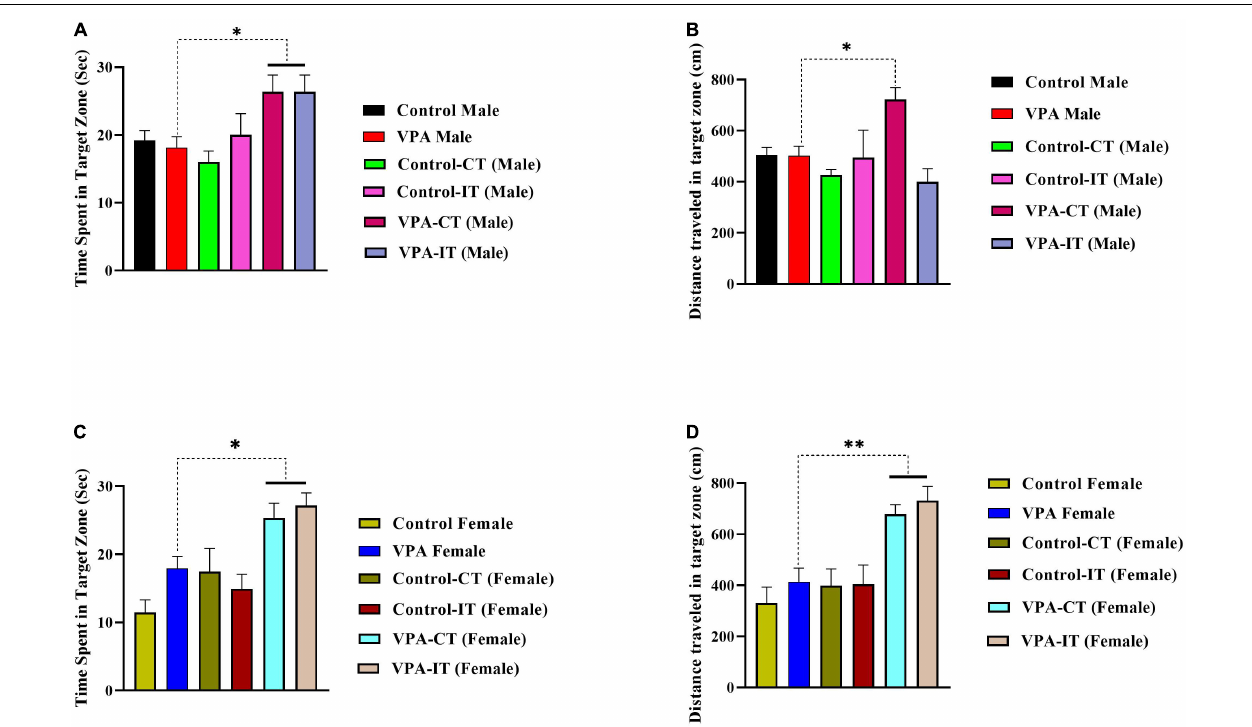
FIGURE 7 | The effects of IT or CT on the MWM probe trial reference memory in the control and VPA-exposed male and female offspring. Both IT and CT exercise trainings in VPA-exposed male rats increased the time spent in the target zone (A) . CT exercise training increased distance traveled in the target zone (B) . In female rats, that both IT and CT exercise trainings in VPA-exposed male rats increased the time spent (C) and traveled distance (D) in the target zone. Data are presented as mean ± SEM. * p < 0.05, ∗∗ p < 0.01, ∗∗∗∗ p <